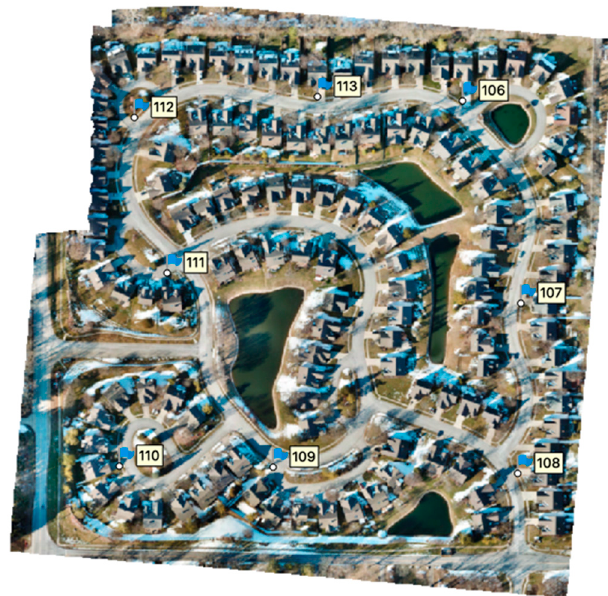
Figure 3. Spatial distribution of GCPs over the study area.